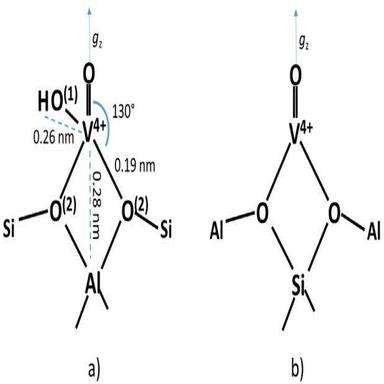
Experimental (black) and simulated (red) 17O HYSCORE spectra of the VCl4- ZSM5 sample. (a) observer position: B0 = 1180.7 mT s = 216 ns; (b) observer position: B0 = 1196.0 mT, s = 144 ns; (c) observer position B0 = 1213.1 mT s = 144 ns and (d) observer position: B0 = 1300.0 mT, s = 144 ns. All spectra were recorded at T = 30 K. The contour level of the simulations as adjusted to the intensity of the experimental spectra.